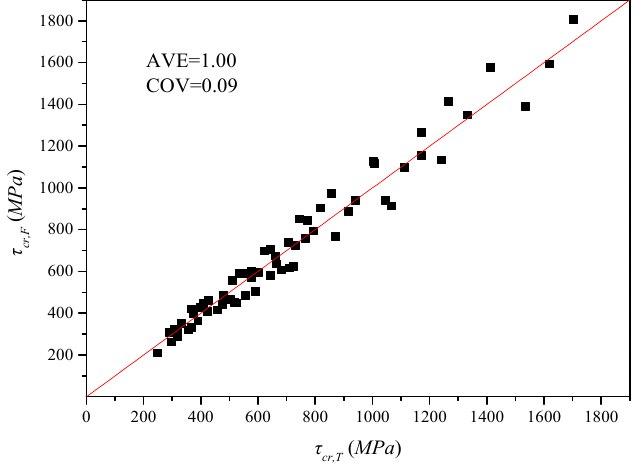
Figure 8. Finite element value τ cr,F versus theoretical value τ cr,T of global elastic shear buckling strength. AVE: average value; COV: covariance